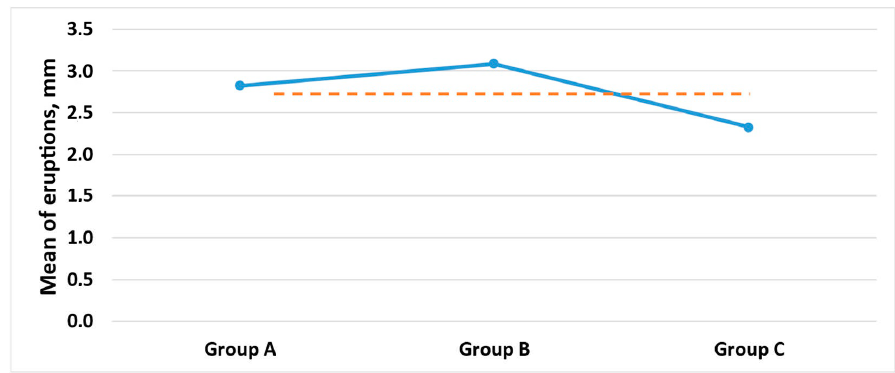
Figure 11. Mean of eruption in mm in the interval T0 ‐ T1.